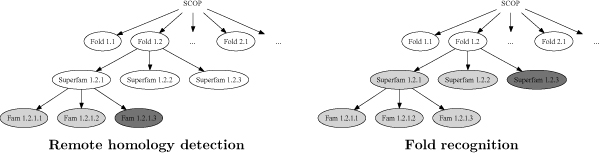
Two protein classification problems. (Left) In the SCOP database, we simulate the remote homology detection problem by holding out a test family (shown in dark gray) from a superfamily and using the other families as positive training data (shown in light gray). The task is to correctly predict the superfamily or fold membership of the held-out sequences. (Right) We simulate the fold recognition problem by holding out a test superfamily (dark gray) from a fold and using the other superfamilies as training data (light gray). The task is to correctly recognize the fold of the held-out sequences.